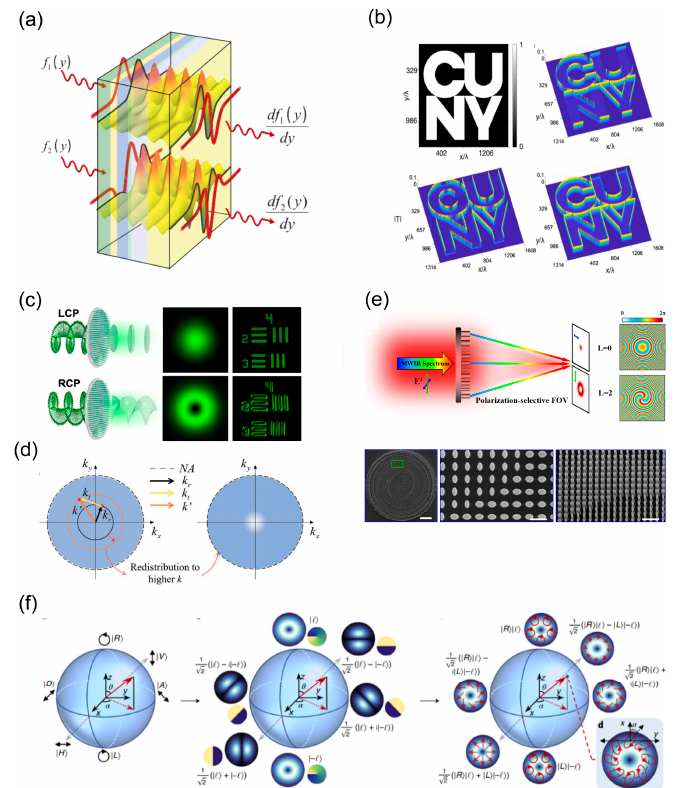
Figure 9. Metasurface-based images processing using structured light fi eld. ( a ) Computational met- amaterial devices based on the Green’s function method [209]. ( b ) Polarization-dependent edge- enhanced imaging [149]. ( c ) Schematic of the Fourier transform setup for spatial fi ltering (upper panel), and results of conversion between bright- fi eld and phase-contrast imaging modes [210]. ( d ) Edge-enhancement e ff ect of the spiral metalens [148]. ( e ) Schematic of the polarization-controlled broadband achromatic spiral metalens [157]. ( f ) Geometric representation of paraxial structured light [212].